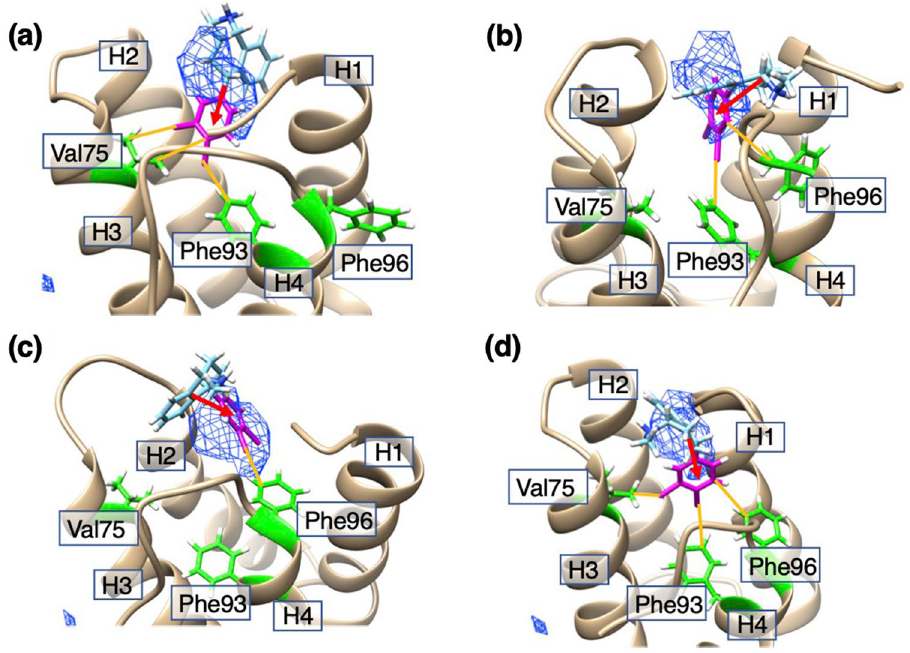
Figure 5. ( a )–( d ) Sertraline–mSin3B complexes picked randomly from the high-density cluster (Cluster A) ( sertraline ) ( r ) > 0.5 ρ 0 ( ρ 0 = 0.001 ), which are shown by blue-colored contours. Magenta-colored portion of ρ CG is Ring A of sertraline. Red-colored arrows are those pointing from the Ring-BC geometrical center to that of Ring A (see Fig. 6a for positions of Ring A and BC). Green-colored residues are Val 75, Phe 93, and Phe 96 of mSin3B. Ocher-colored lines represent contacts between sertraline and the three residues. Labels H1,…, H4 are helices 1–4 of mSin3B (PAH1